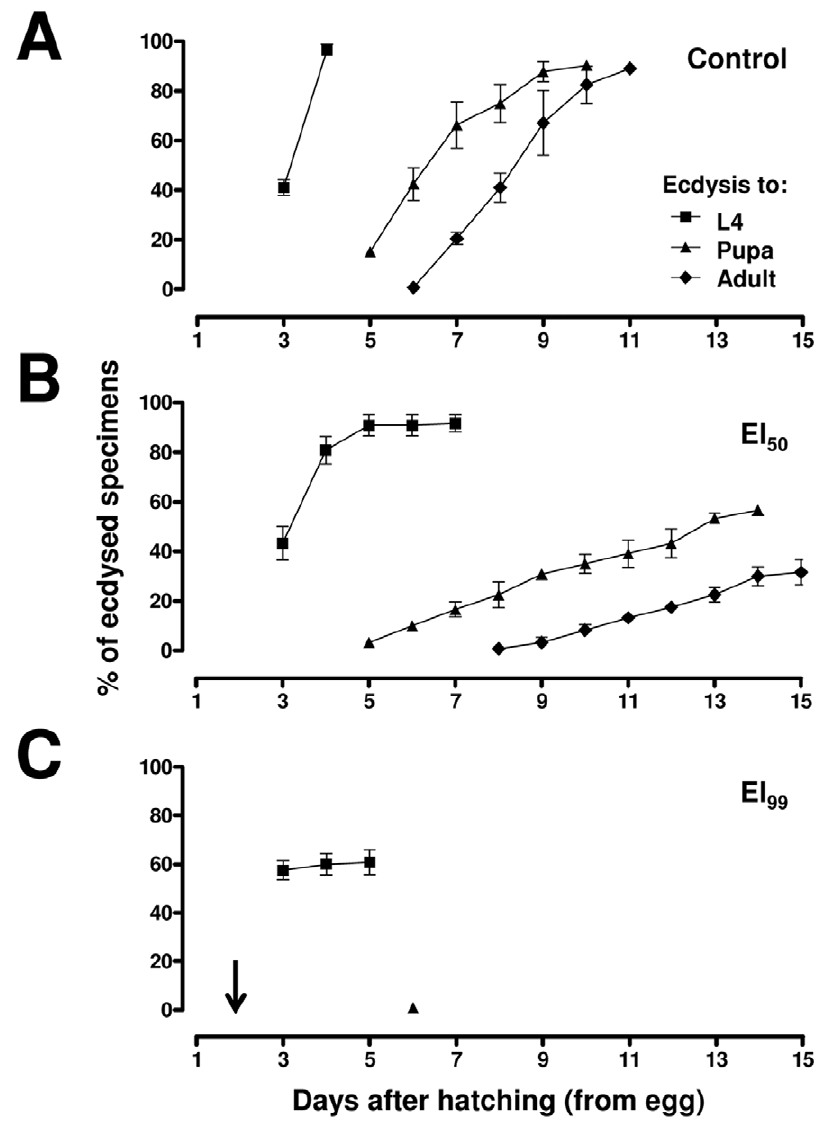
Figure 2. Novaluron induces delay in the development of Ae.aegypti immatures. Symbols represent the cumulative percentage of specimens in relation to eliminated exuviae of the preceding instar: squares, triangles and lozenges indicate newly emerged L4, pupae and adults, respectively. ( A ) control; ( B ) EI 50 and ( C ) EI 99 . Bars represent the standard deviation of three independent experiments. Arrow indicates the moment of novaluron administration (see